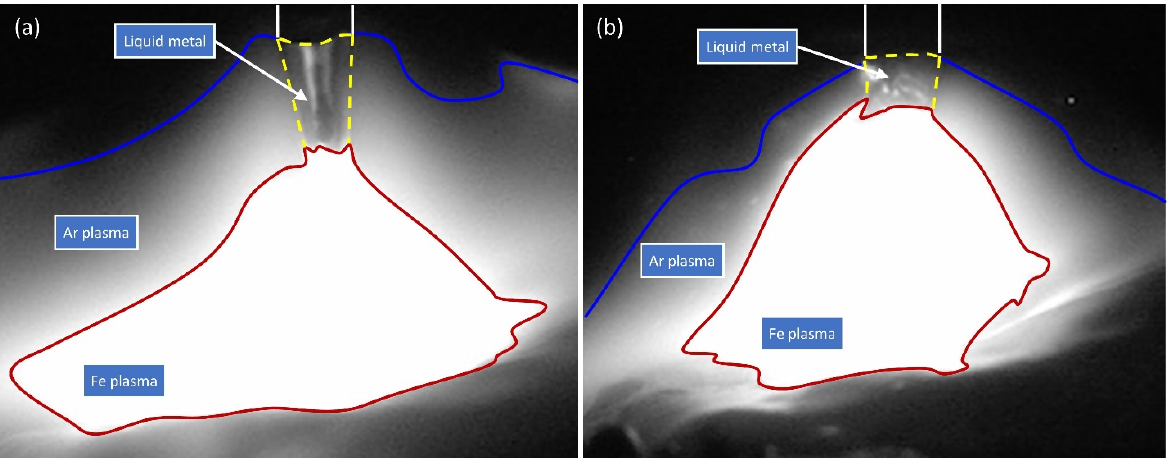
Figure 7. Typical image of arc behavior in solid wire ( a ) and metal ‐ cored wire ( b ) at welding current of 280 A.